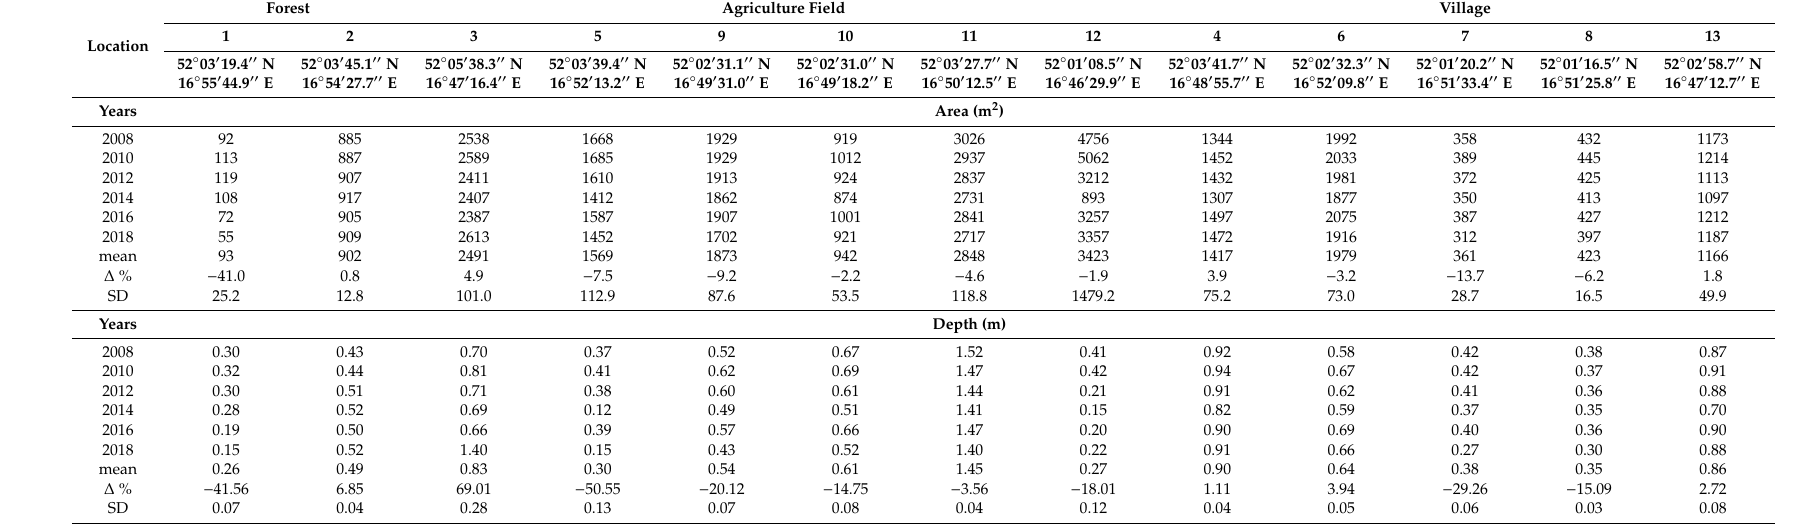
Table 1. The morphometric parameters of